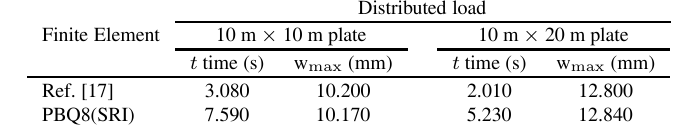
Table 2 Comparison of maximum displacement of plate on elastic foundation